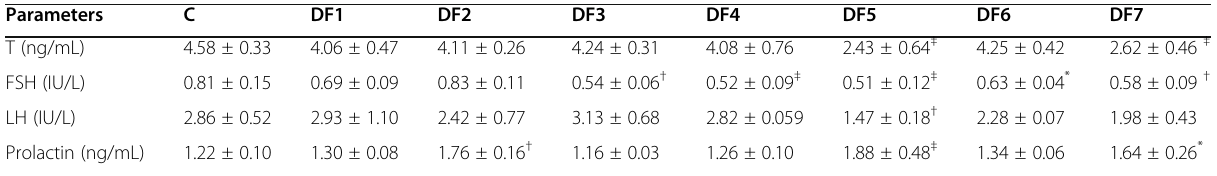
Table 10 Effect of chromatographic fractions of Waltheria indica Linn . root on reproductive hormones of male Wistar rats (Mean ± SD, n = 5 for each group) Parameters C